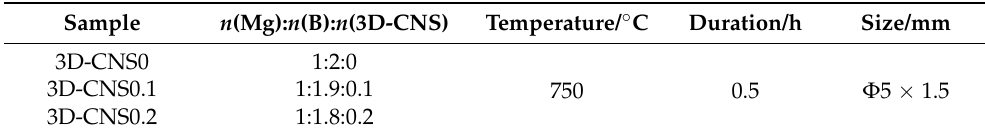
Table 1. Overview of parameters for preparing composite samples.